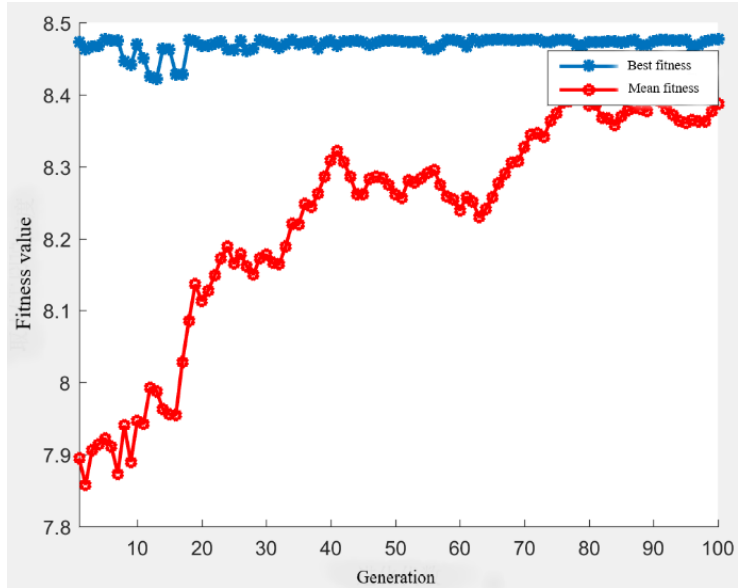
Figure 3. Convergence trend of the solution algorithm for single scheduling model.